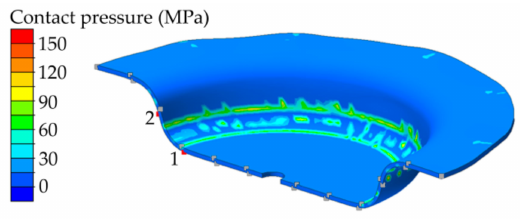
Figure 13. FE-simulated distribution of the contact pressure between tool and workpiece during forming of the cup of X46Cr13 after austenitization at 1050 ◦ C for 300 s and subsequent start of forming at 900 ◦